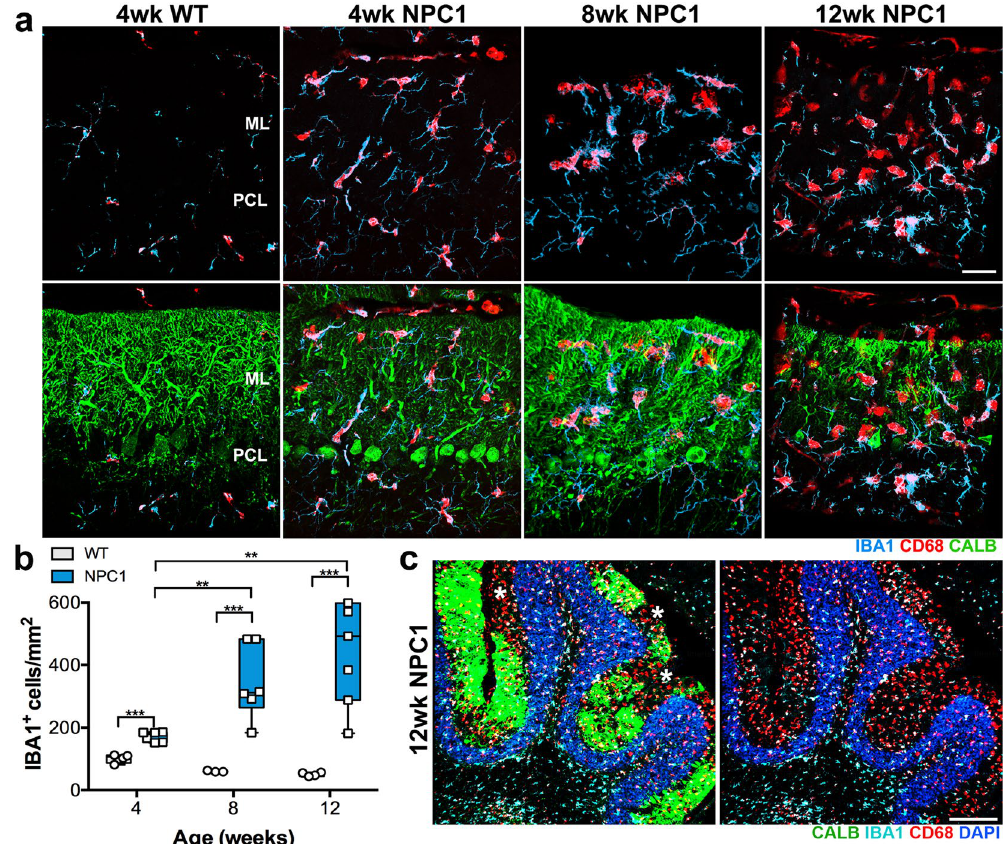
Figure 2. Pathological changes in microglia are found early and exacerbated with age in the Npc1 nmf164 mouse. ( a ) Representative images from 4, 8, and 12 weeks old mice showing IBA1 + microglia cells (cyan) containing CD68 + phagosomes (red) at the ML where CALB + dendrites from PC (green) reside. Changes in microglia morphology, and in the density and content of phagosomes, were already evident in 4 weeks old Npc1 nmf164 mice and exacerbated at later stages when compared to WT mice. ( b ) The density of IBA1 + microglia were increased at 4, 8 and 12 weeks of age in Npc1 nmf164 mice when compared to WT mice (n = 3–4 per age). ( c ) Representative images of anterior cerebellar lobules immunostained with CALB, IBA1 and CD68, showing regional loss of PCs, and massive invasion of microglia cells at the ML in a 12 weeks old Npc1 nmf164 mouse. Data are presented as mean ± SEM n = 6–7. ** P < 0.01, and *** P < 0.001. Scale bars: ( a ) 30 μ m and ( c ) 200 μ